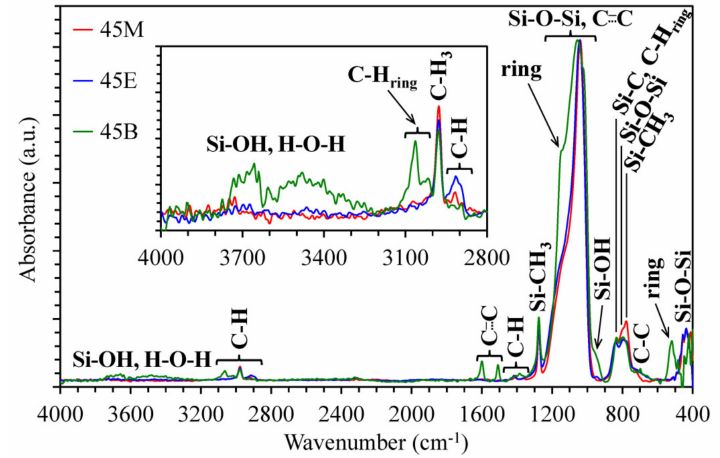
Figure2. FTIRspectraofperiodicmesoporousorganosilicafilmswithdifferentbridges(45M—methylene,